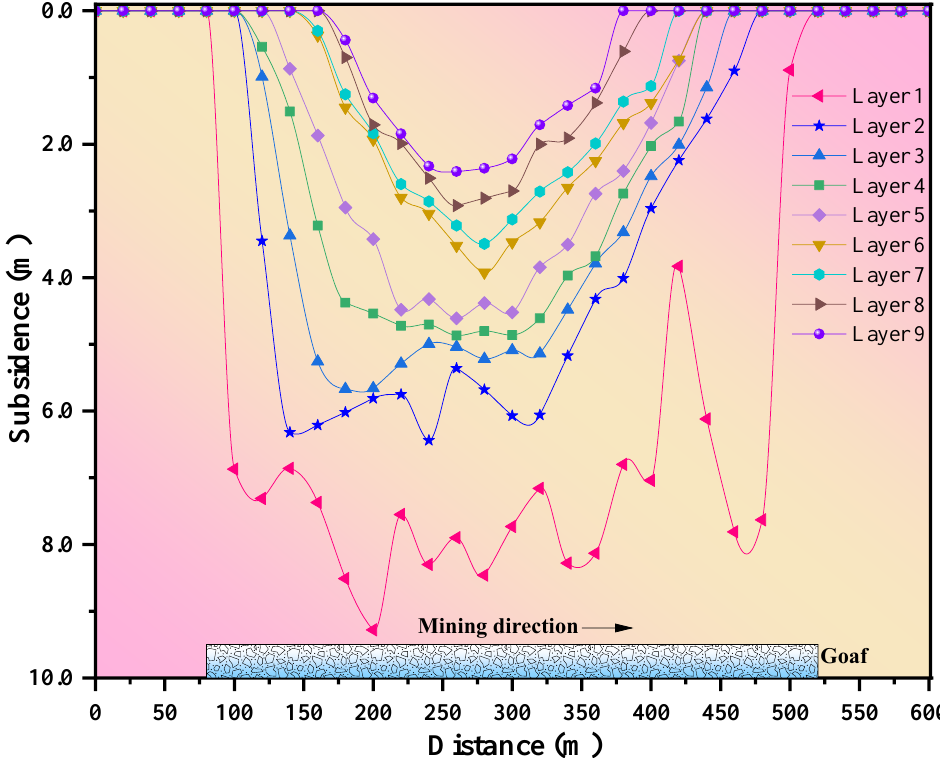
Figure 12. Roof rock subsidence after full mining.